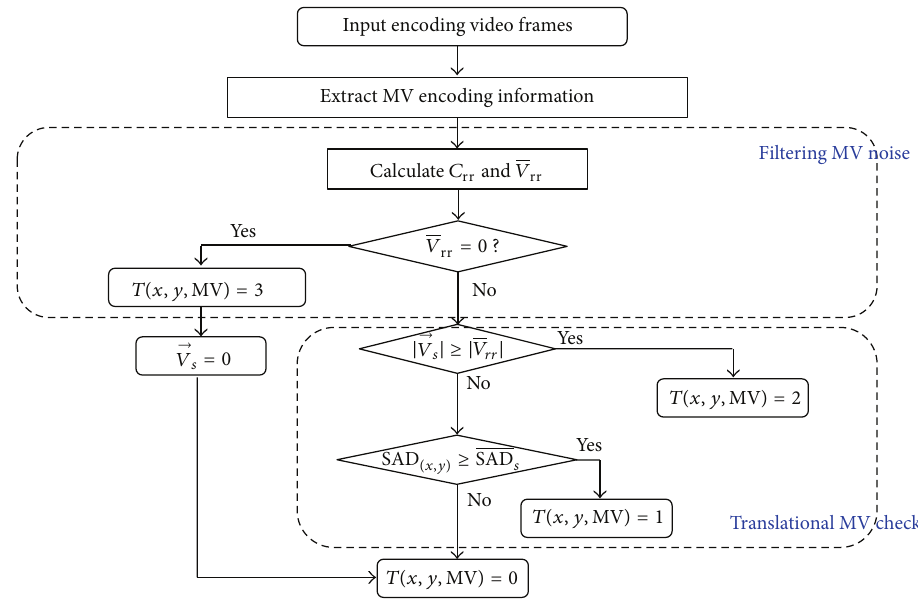
Figure 10: Flow chart of temporal saliency